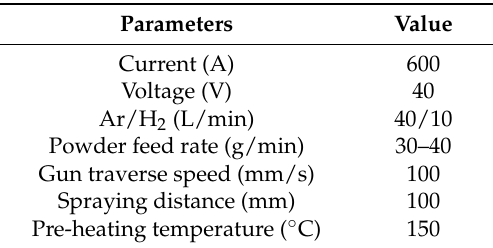
Table 2. Plasma spraying operation